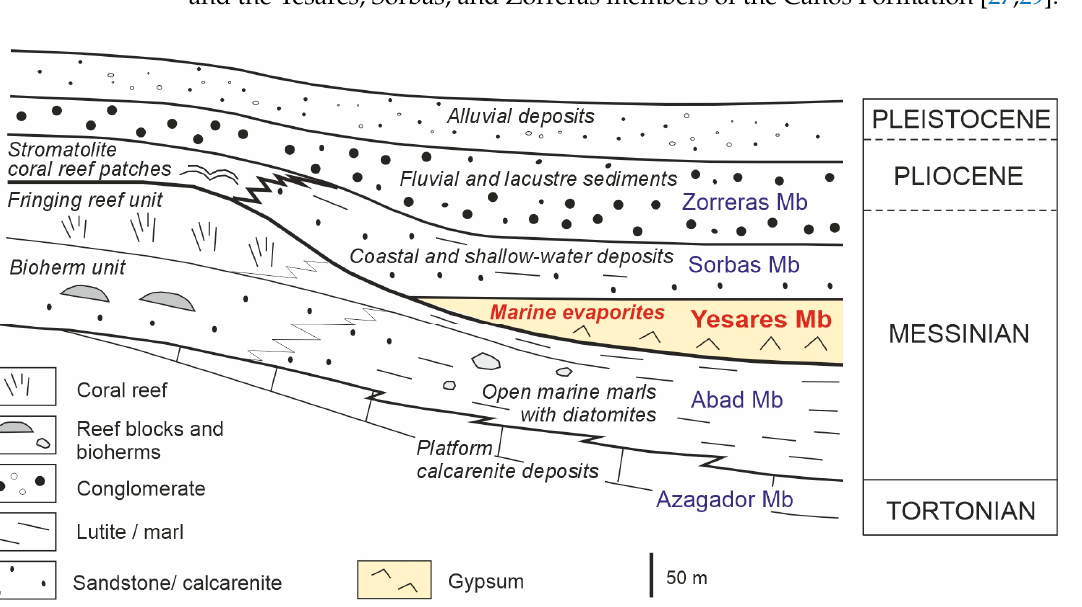
Figure 2. Panoramic view (N–S) of the studied area. The continuity of the gypsum banks can be observed with a gentle dip to the north.